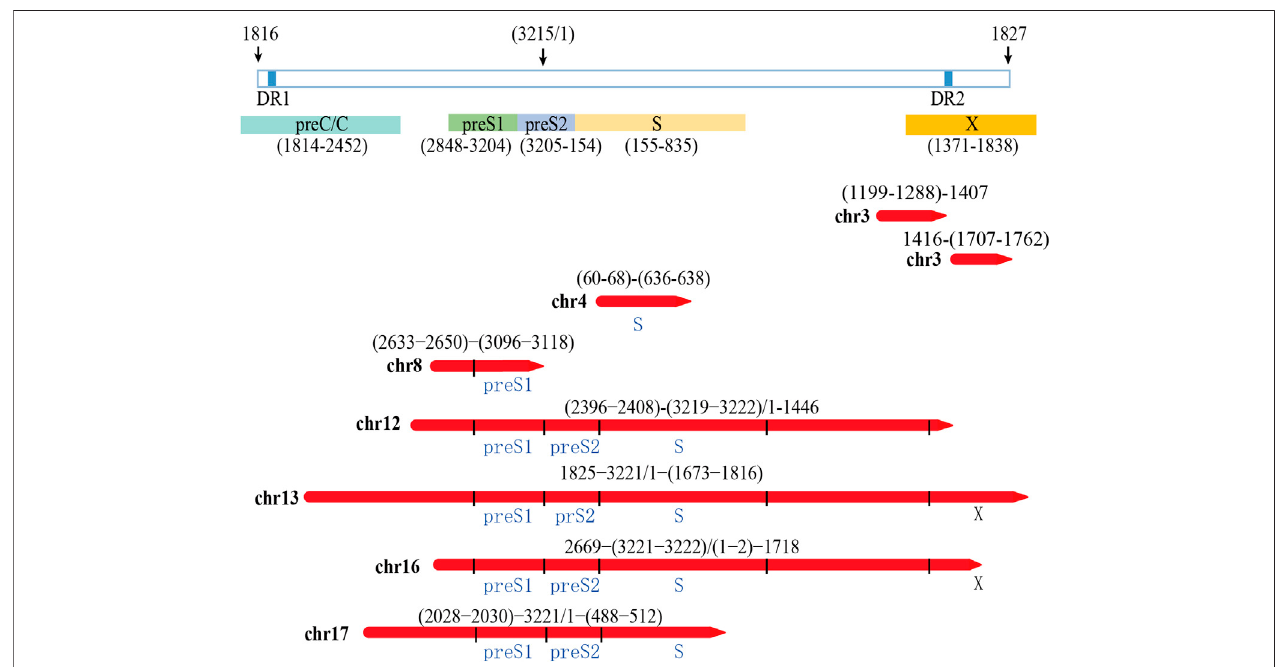
FIGURE 5 | Analysis of the possibility of integrating HBV fragment sequences expressing HBV viral proteins